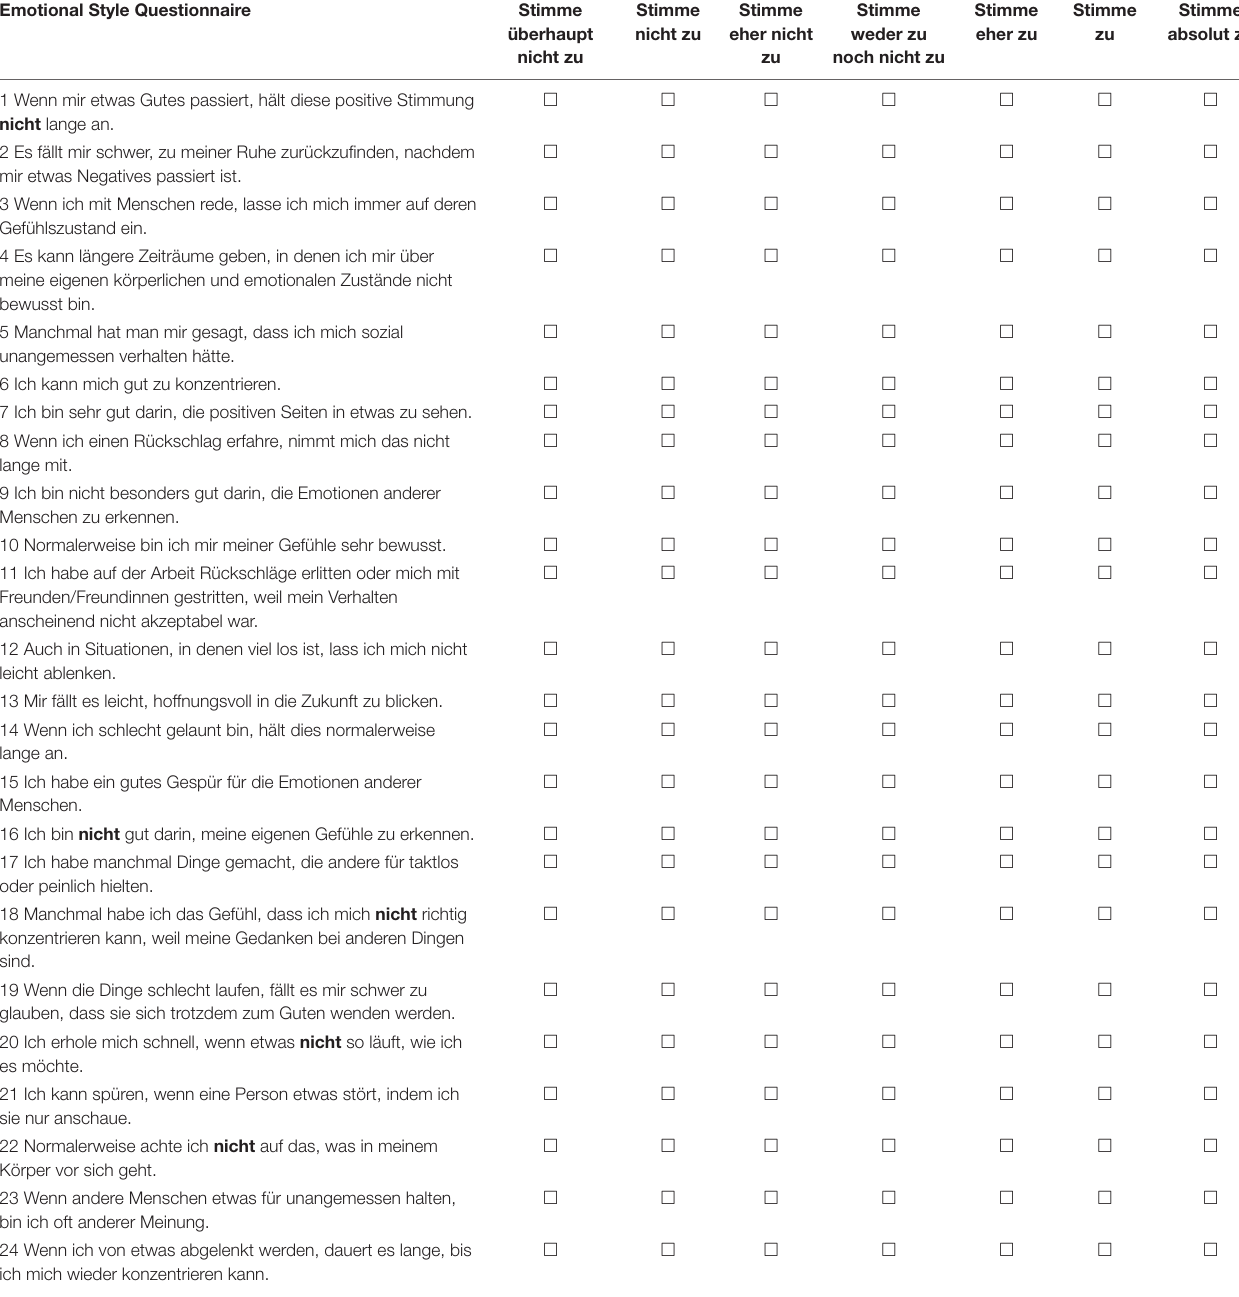
TABLE A1 | Emotional Style Questionnaire (ESQ)–German